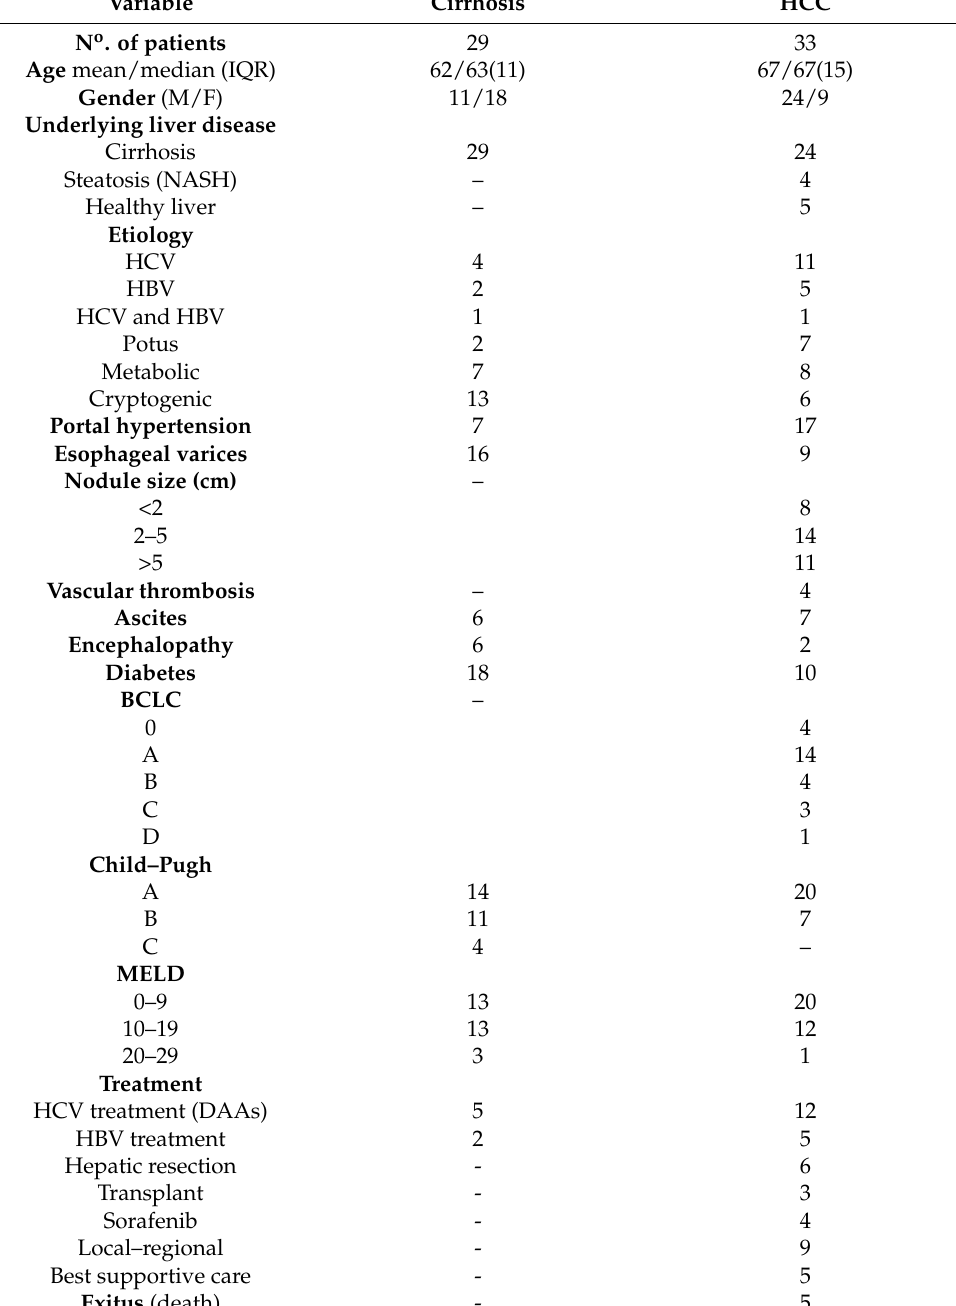
Table 1. Clinical and demographic parameters of the study